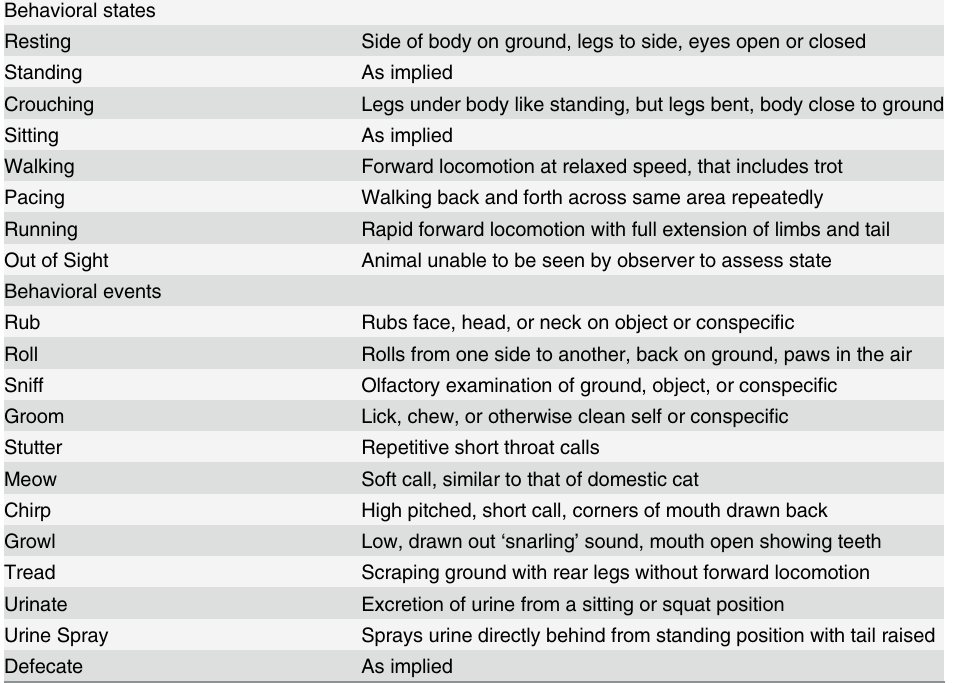
Table 2. Definitions of observable state and event behaviors for male